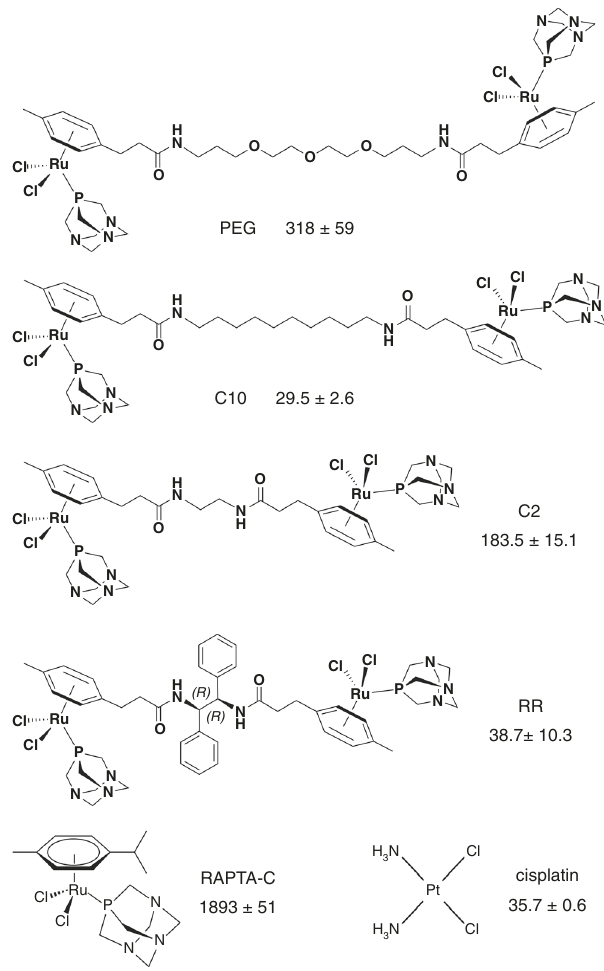
Fig. 1 Structures and cytotoxicity parameters of compounds used throughout the study. Cell growth inhibition, IC 50 , values ( μ M; HeLa cells, 40 h) are shown (mean ± s.d., n =